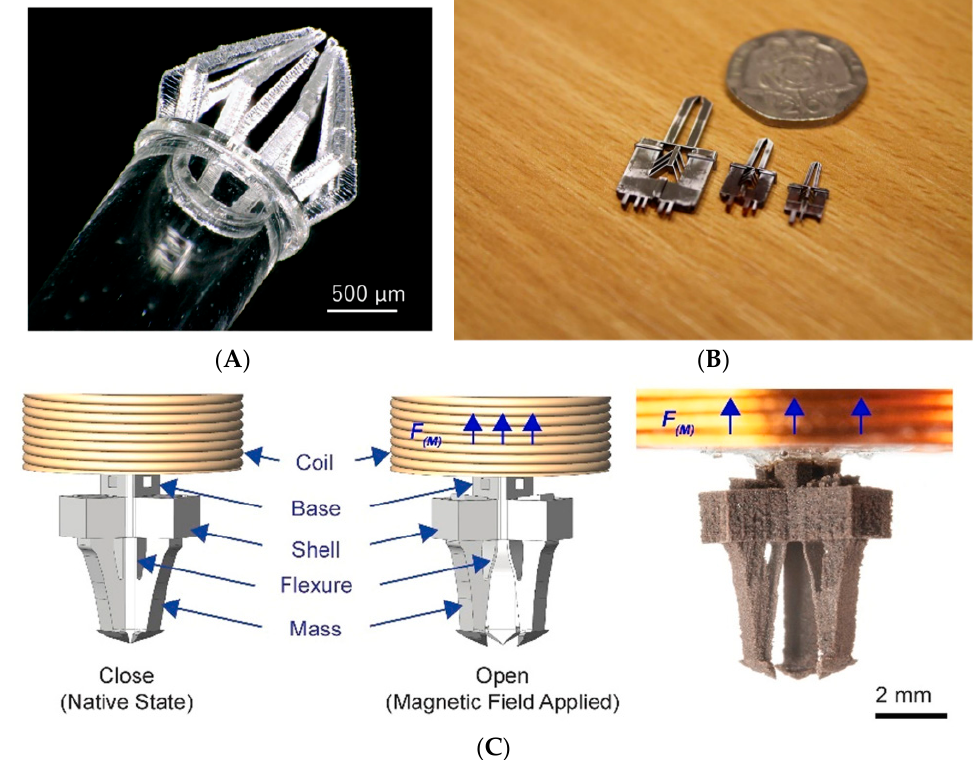
Figure 1. Examples of fabricated micro-grippers: ( A ) Micro-gripper for handling microstructure spheroids, mounted on a glass capillary. Reprinted with permission from Ref. [86]. Copyright 2020 MDPI. ( B ) Fabrication of a thermally actuated micro-gripper using a sputter-coating process for the deposition of metallic layers on polymer parts. Reprinted with permission from Ref. [88]. water. Reprinted with permission from Ref. [82]. Copyright 2021